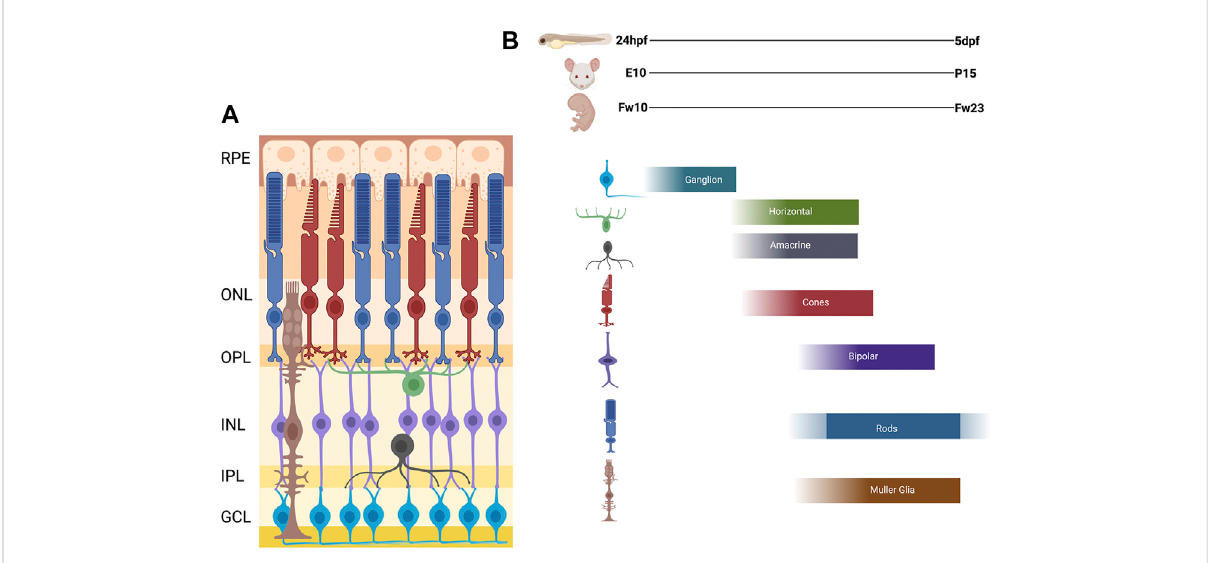
FIGURE 2 Schematic of Vertebrate Retina and Order of Retinal Cell Differentiation. (A) Diagram of vertebrate retina. The retina is composed of three nuclearlayers:OuterNuclearLayer(ONL),theInnerNuclearLayer(INL),andtheGanglionCellLayer(GCL),andtwoplexiformlayers:Outerplexiform later (OPL) and Inner Plexiform Layer (IPL). The synapses for the photoreceptors, horizontal, bipolar are in the OPL and amacrine, bipolar, and ganglion are in the IPL. (B) The order of retinal cell differentiation is conserved across zebra fi sh, mouse and human. Most of this cell differentiation occurs between 24 h post fertilization (hpf) to 5 days post fertilization (dpf) in zebra fi sh, embryonic day 10 (E10) to post-natal day 15 (P15) in mouse, and fetal week 10 (Fw10) to fetal week 23 (Fw23) in humans. Figure created with